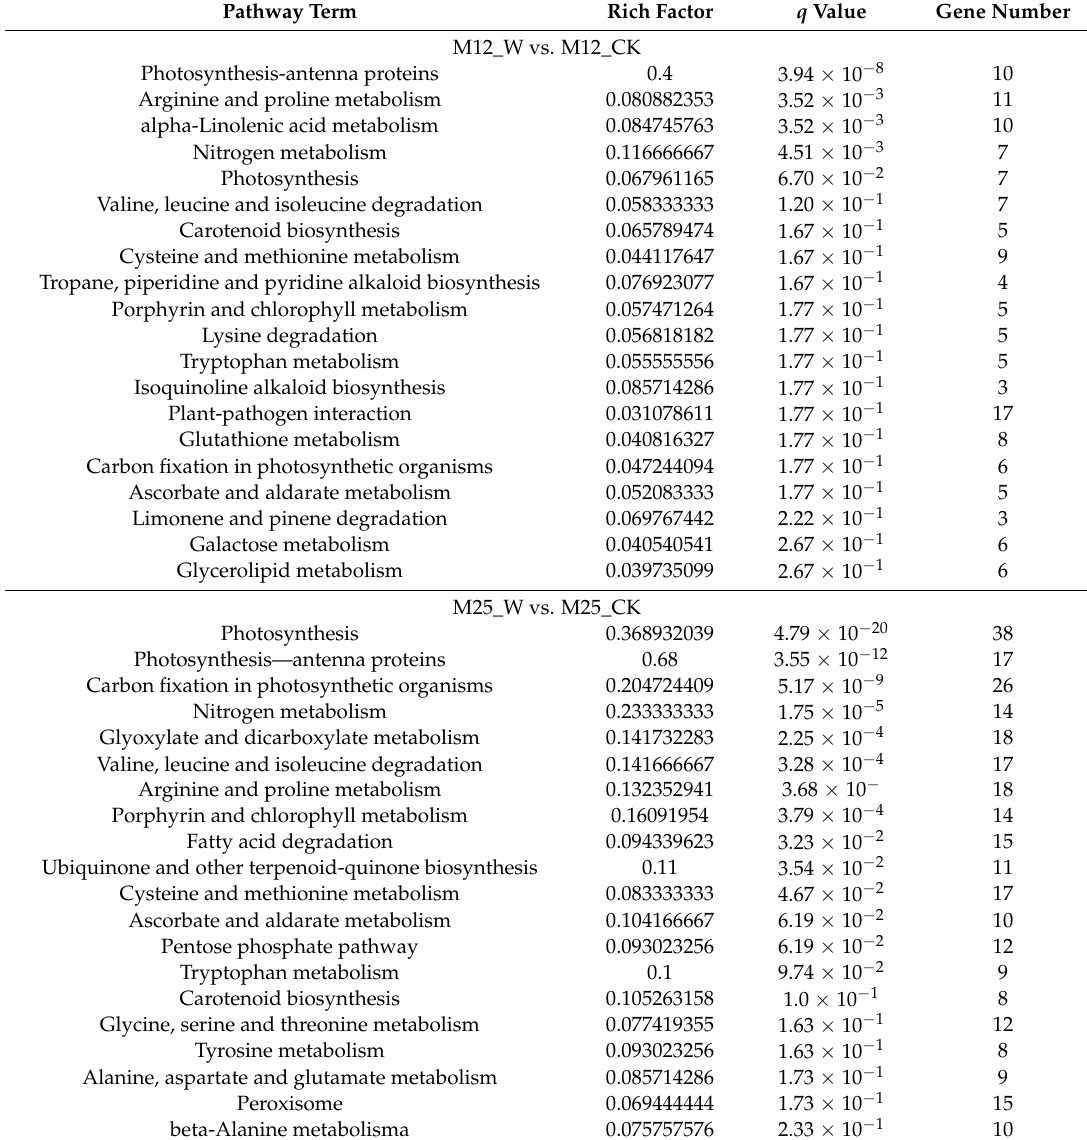
Table 3. Top 20 differentially abundant transcripts (DATs) enriched in Kyoto Encyclopedia of Genes and Genomes (KEGG)